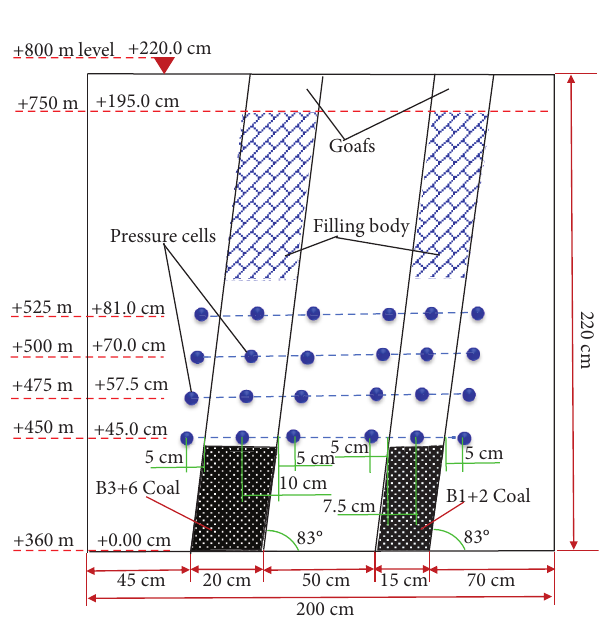
Figure 2: The layout of monitoring